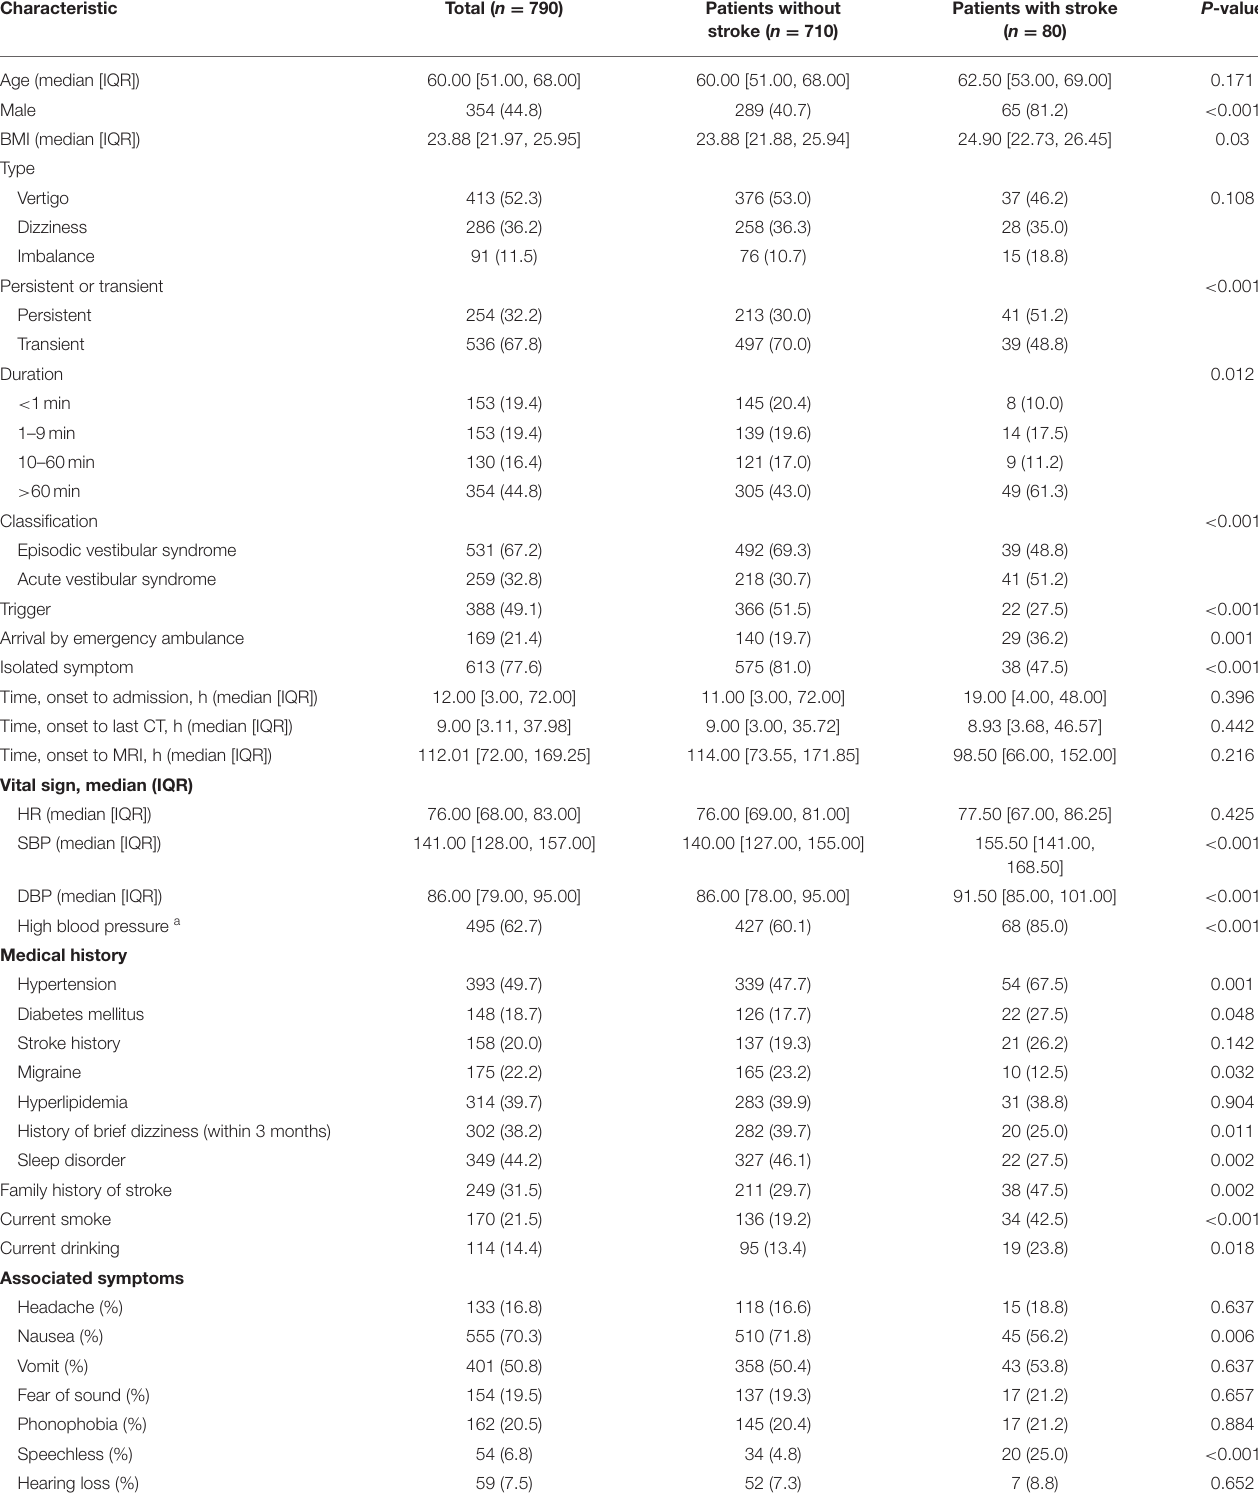
TABLE 2 | Demographic and clinical characteristics of 790 patients with dizziness/vertigo or imbalance. Characteristic Total ( n = 790) Patients without